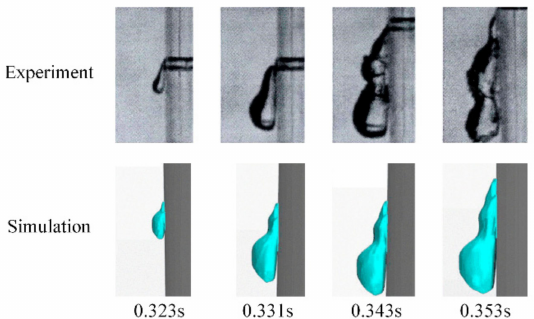
Figure 5. Comparison between numerical and experimental results of cavity.